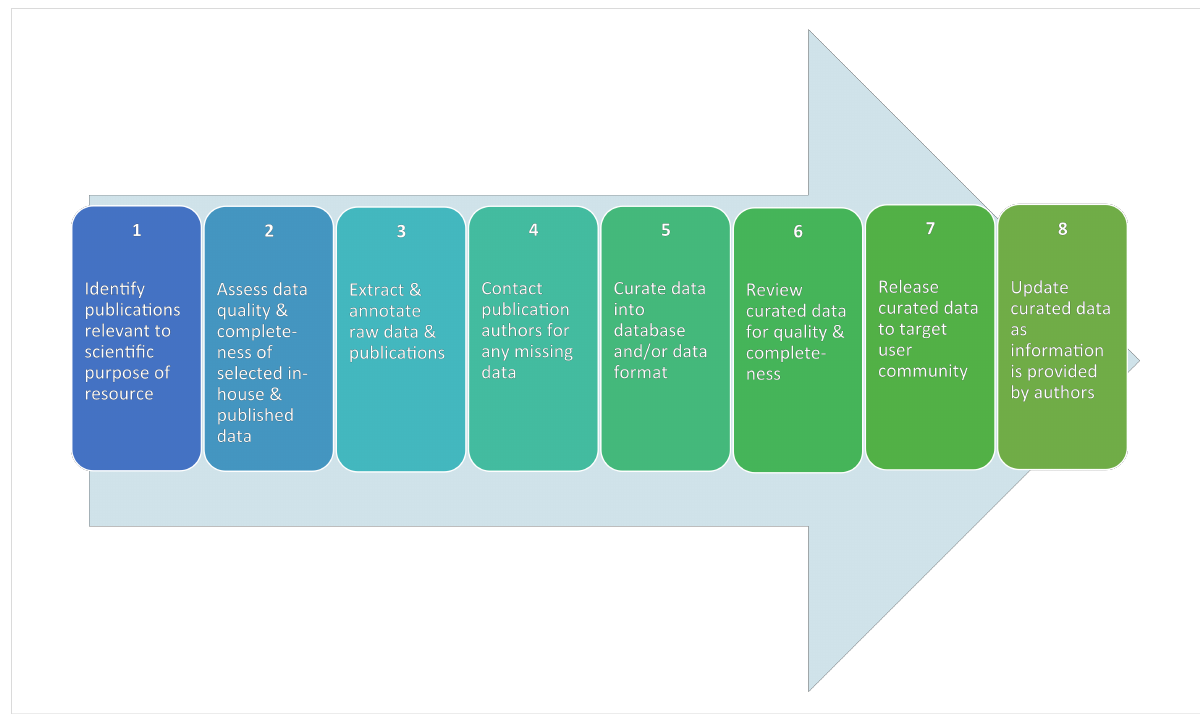
Figure 1: Common steps in nanocuration. The steps commonly included in nanocuration workflows are illustrated, including: 1) Identification of publi- cations relative to the intended scientific purpose; 2) Preliminary assessment of data quality and completeness of selected in-house or publication data for data quality and completeness (with assumption that any in-house data would be pre-identified within a project prior to the wider publication search referred to in Step 1); 3) Data extraction of raw data and/or data from the publication; 4) Communication with publication authors; 5) Curation of data into the intended repository and/or data format (e.g., ISA-TAB-Nano) leveraging common data elements (CDEs) from relevant ontological resources (e.g., NanoParticle Ontology [NPO]); 6) Review of curated data for data quality and completeness; 7) Release of curated data; 8) Update of curated data as additional information is received from the authors. Though shown here in linear fashion, the order of these common steps for an indi- vidual process may be flexible and iteration is expected. The specific steps in a workflow may also differ across repositories depending on the intended purpose of the nanomaterial